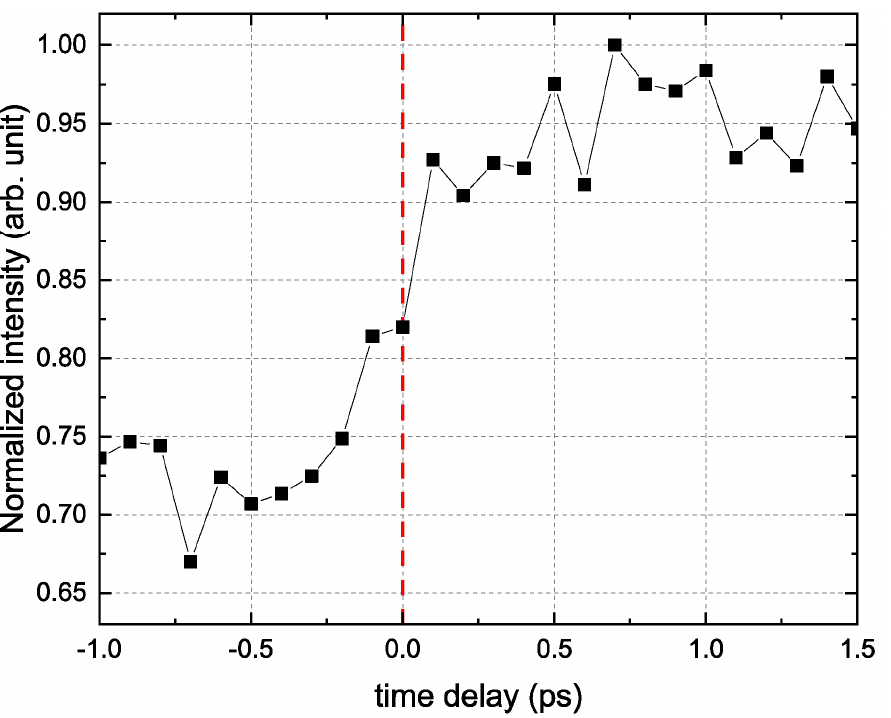
Figure 5. Timing synchronization of two light sources with femtosecond precision using a Ce:YAG. The intensity of the transmitted IR laser is kept constant at negative delays. The intensity is reduced when X-ray pulses arrive first.